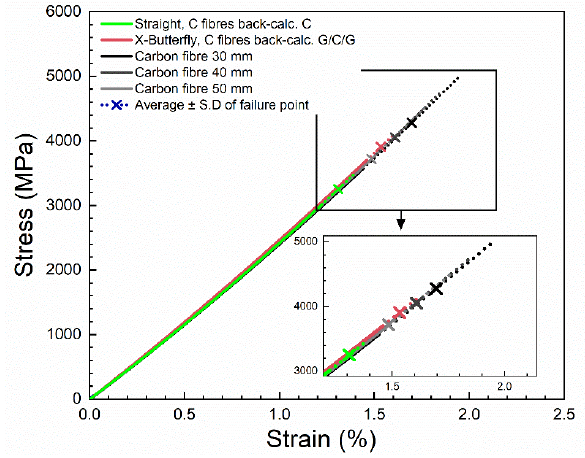
Figure 15. Fitted stress–strain curves of single carbon fibres and back-calculated stress–strain curves of carbon fibres from composites.